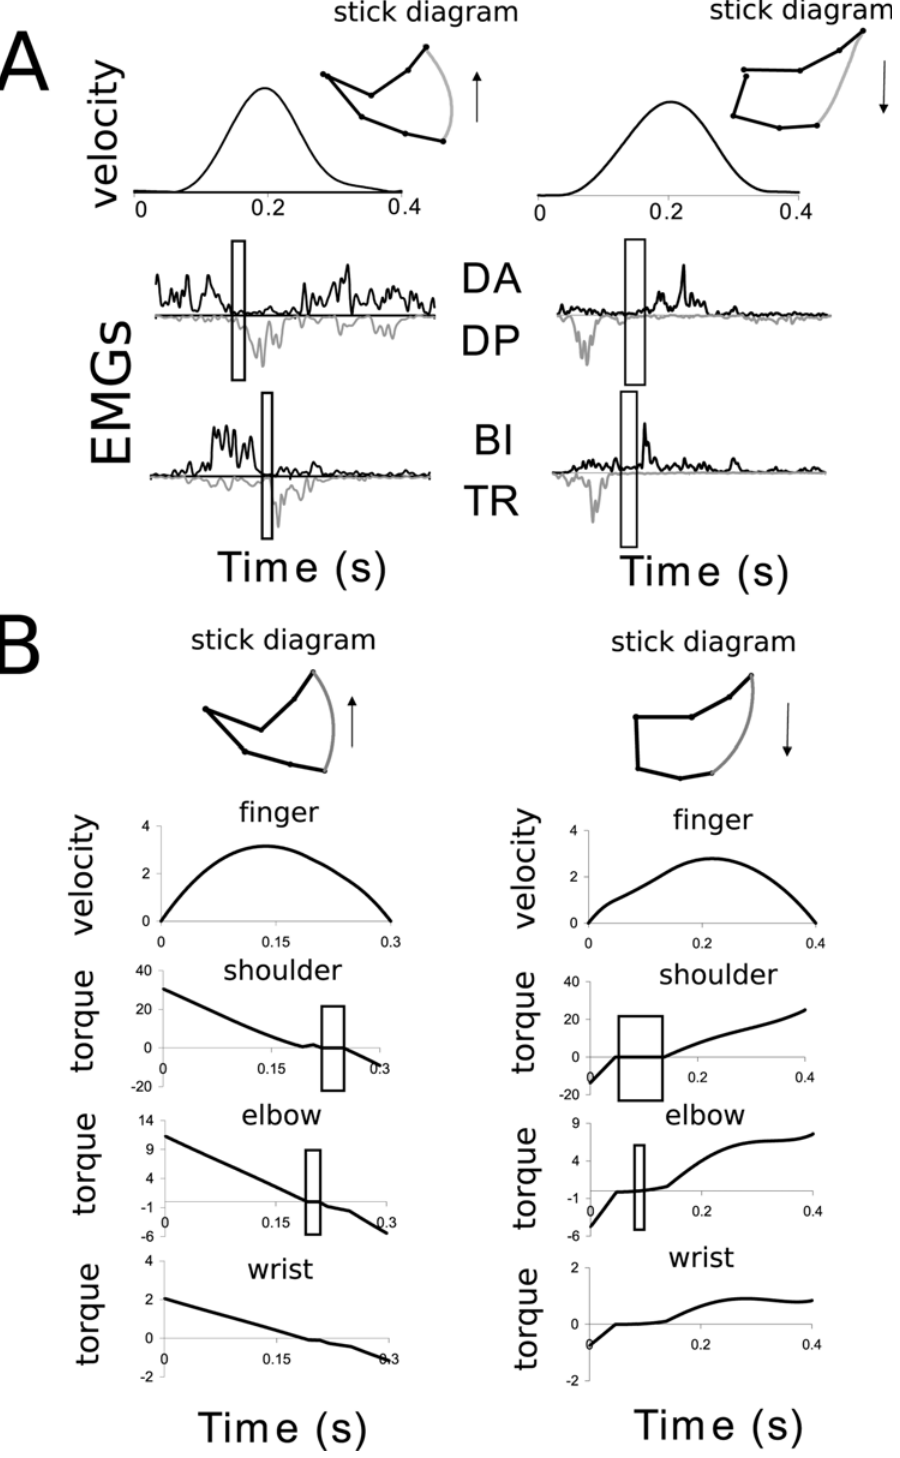
Figure 5. Typical experimental data of a 3-dof vertical arm motion performed in upward (left) and downward (right) directions. (A) Experimental results. Finger velocity profiles (upper part) and four electromyographic signals (lower part) are amplitude normalized. (B) Simulated results. The shoulder, elbow and wrist joints were free to move. Torques and velocity are given in N.m and m/s, respectively. The solutions were computed using Pontryagin’s Maximum Principle (as for the 2-dof case depicted in the Materials and Methods Section, but with more complicated formulae). Moreover, the transversality conditions of Pontryagin’s Maximum Principle were necessary since the location of the target in task-space led to a set of possible terminal postures, given by a 1-dimensional manifold. The periods of muscular inactivation are emphasized by means of rectangular frames. The same abbreviations as in Figure 3 are used.